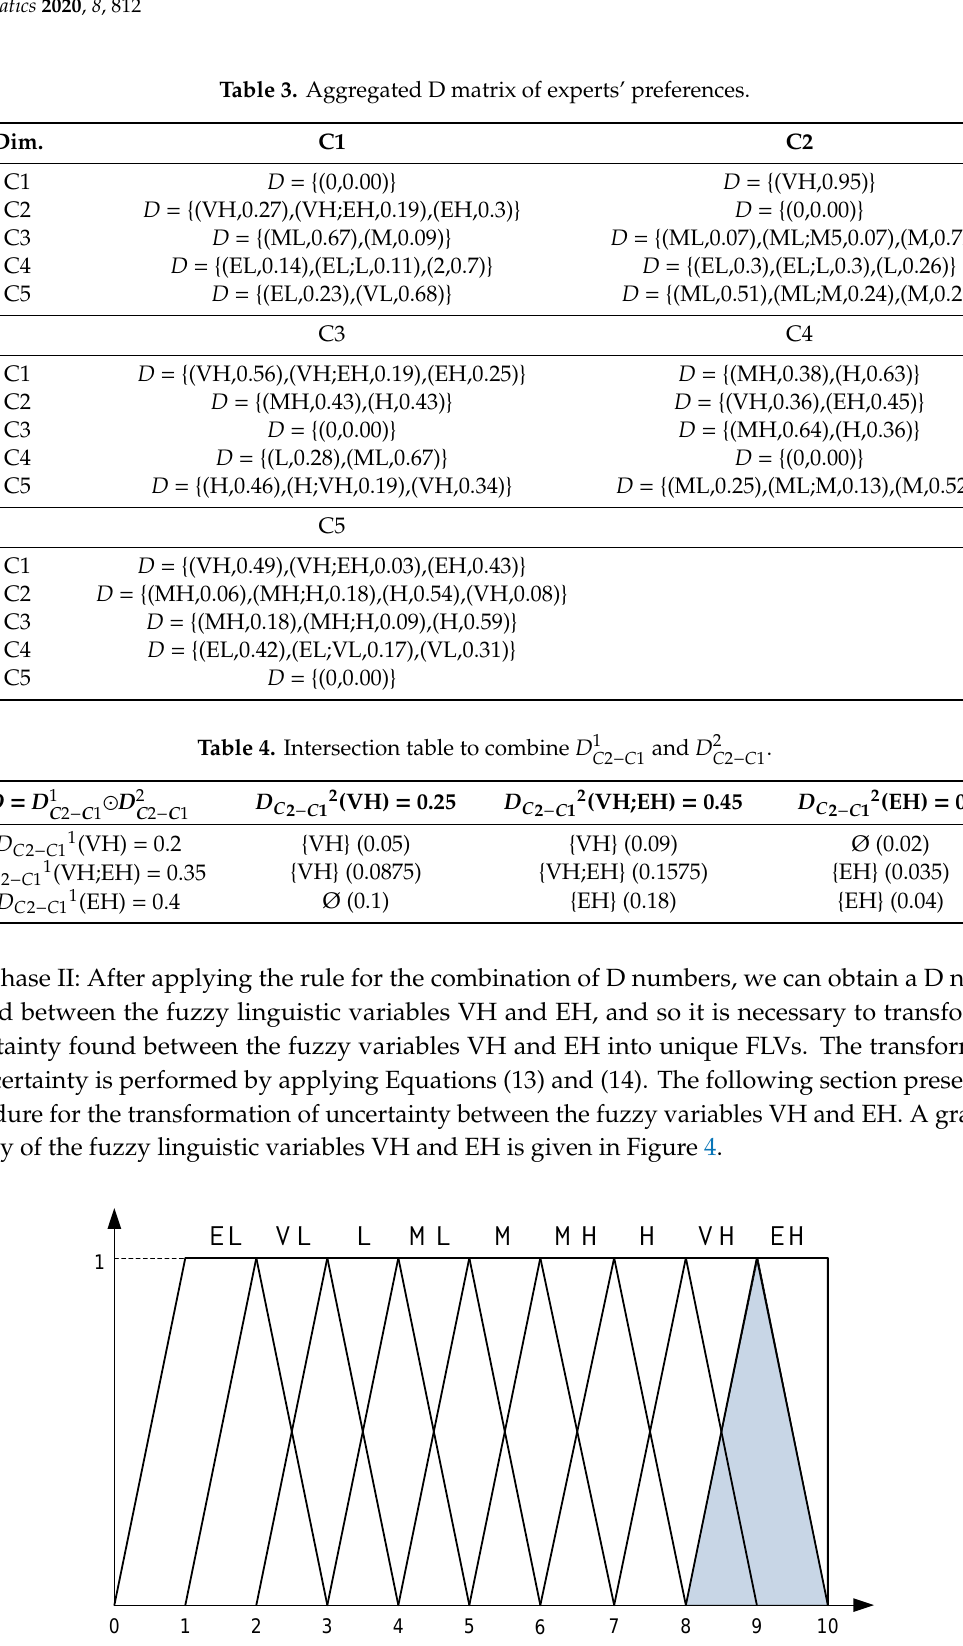
Figure 4. Fuzzy linguistic variables VH (very high) and EH (extremely high).